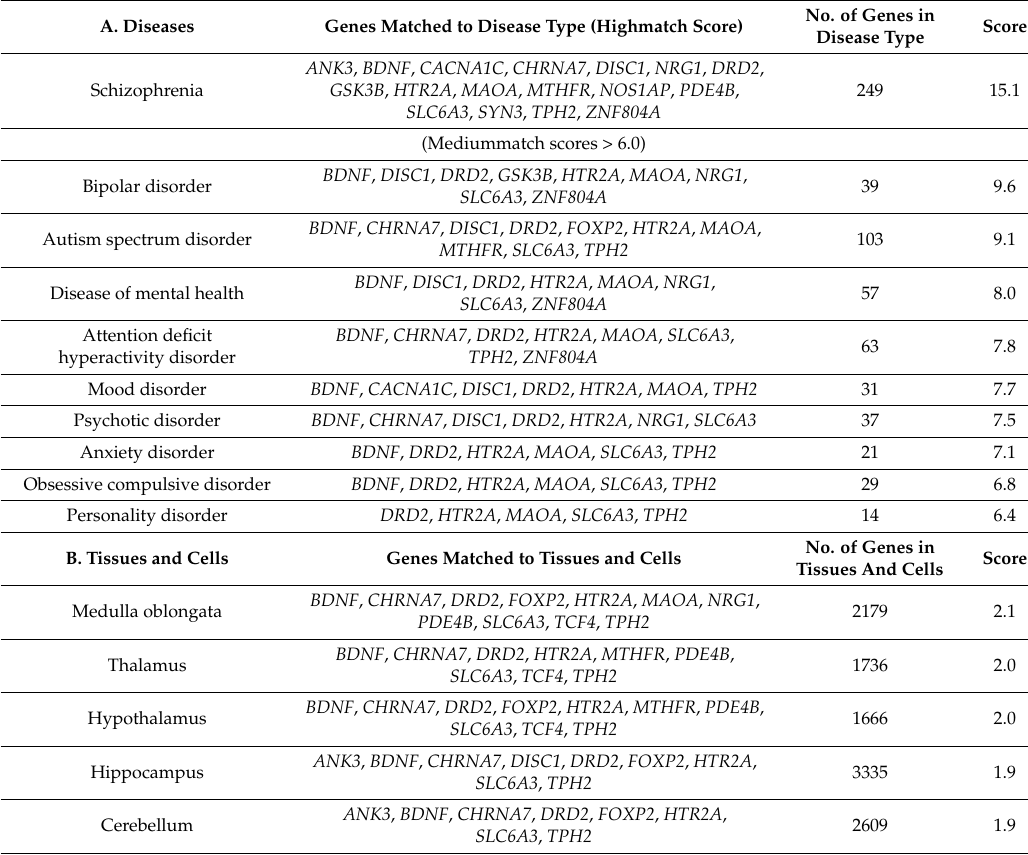
Table 2. GeneAnalytics program mapping of diseases, tissues and cells that were significantly matched to 23 overlapping genes for autism spectrum disorder, bipolar disorder and